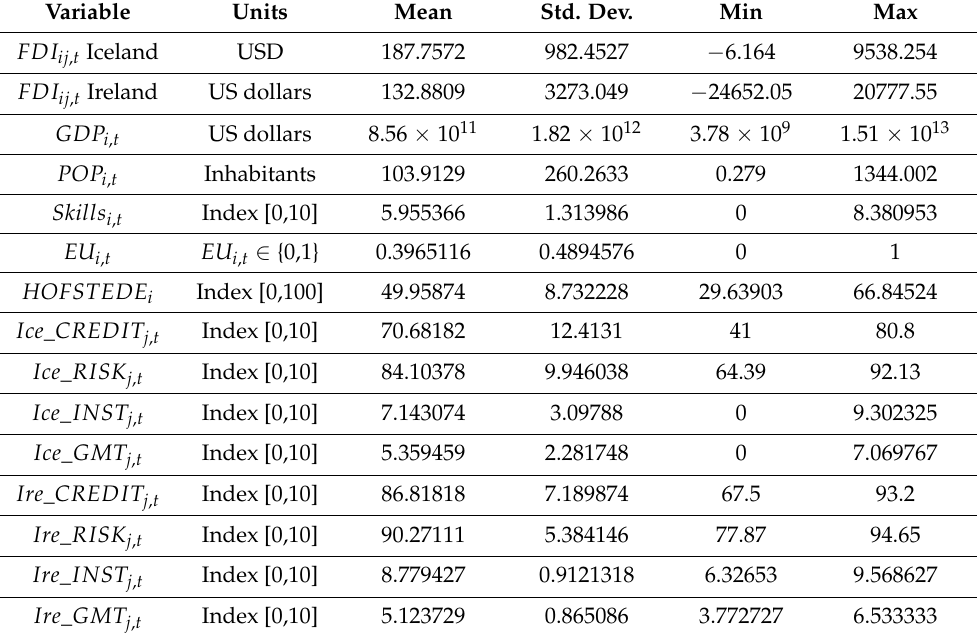
Table 2. Summary Statistics for the Basic